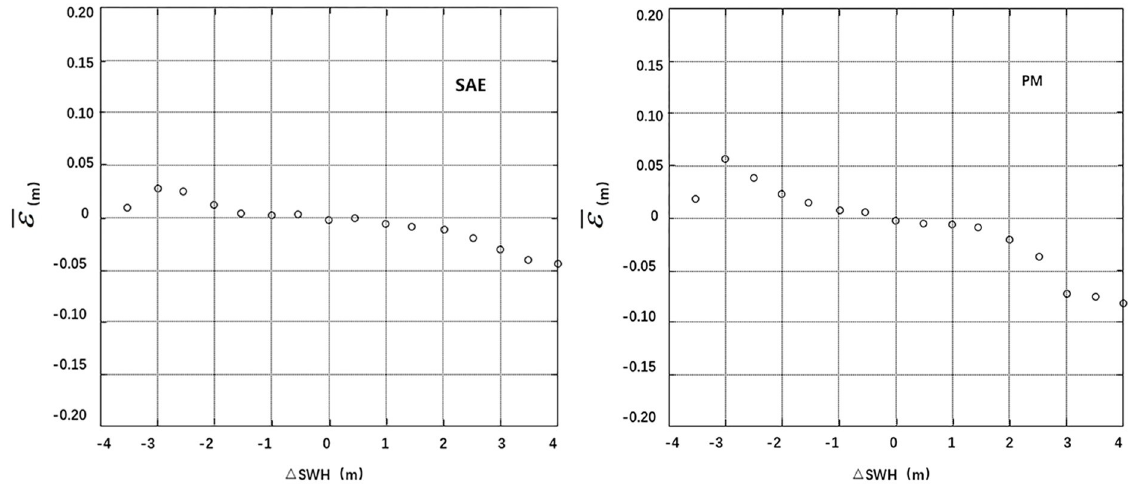
Fig 4. Distributions of mean residuals � ε according to Δ